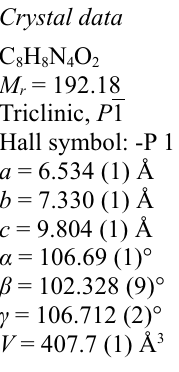
Figure 2 Thermal ellipsoid (Barbour, 2001) plot of the layered structure arising from O –H 4-Amino-3-(4-hydroxyphenyl)-1H-1,2,4-triazol-5(4H)-one Crystal